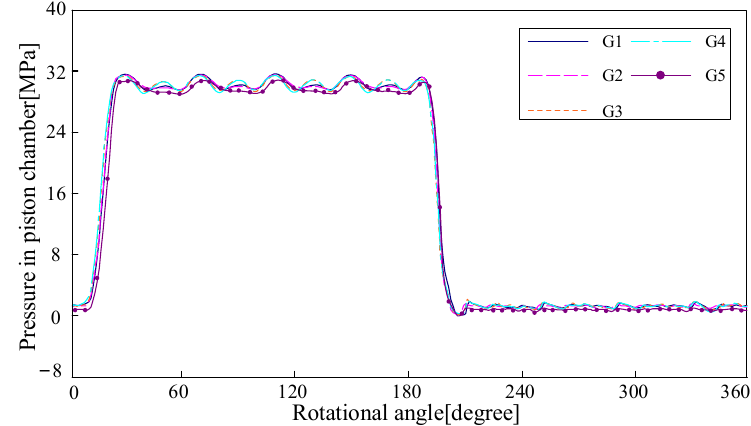
Figure 12. Pressure in piston chamber with different slot geometries.